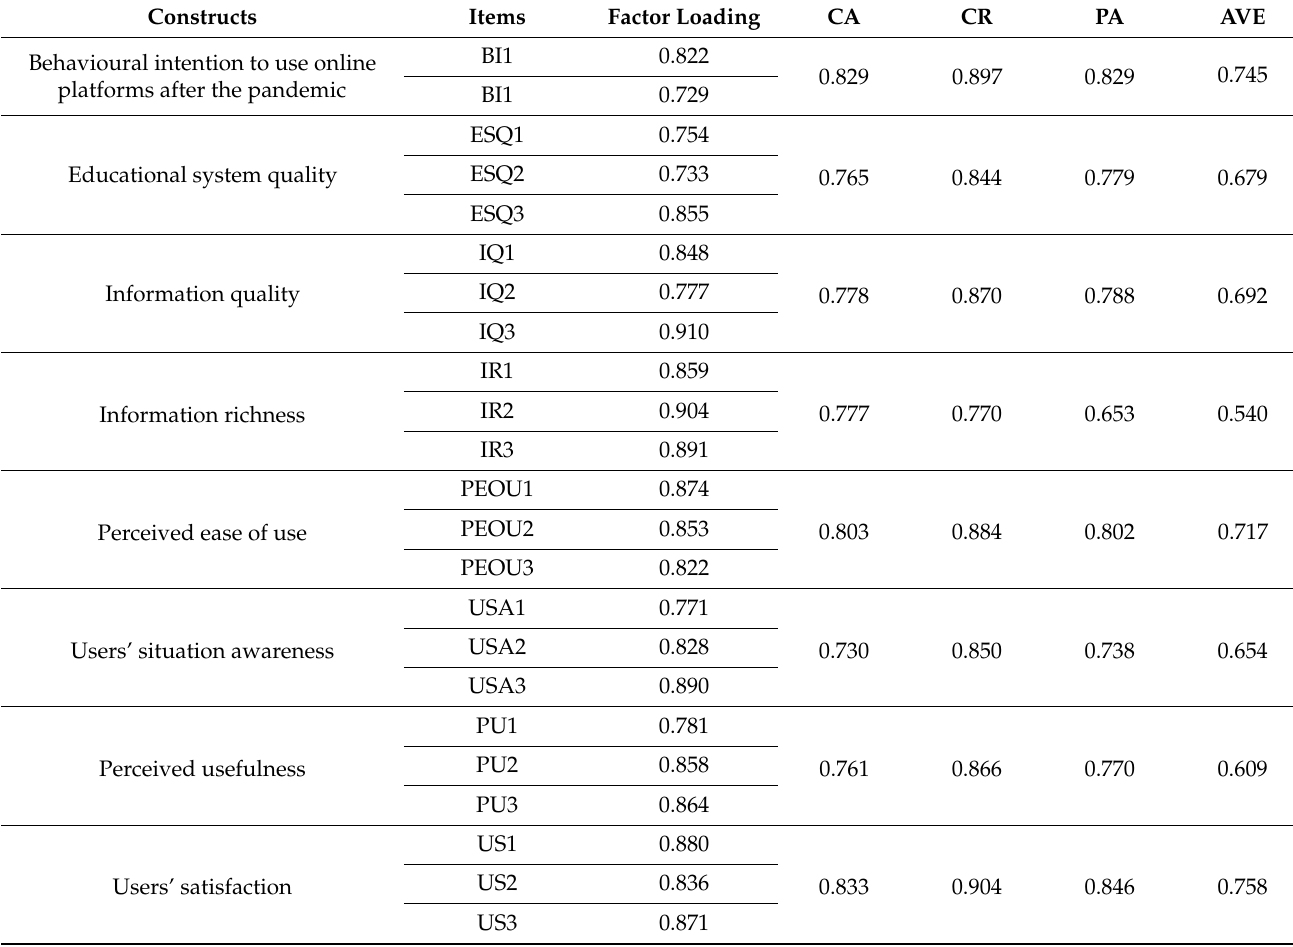
Table 5. Convergent validity results that assure acceptable values (factor loading, CA, CR ≥ 0.70 and AVE >